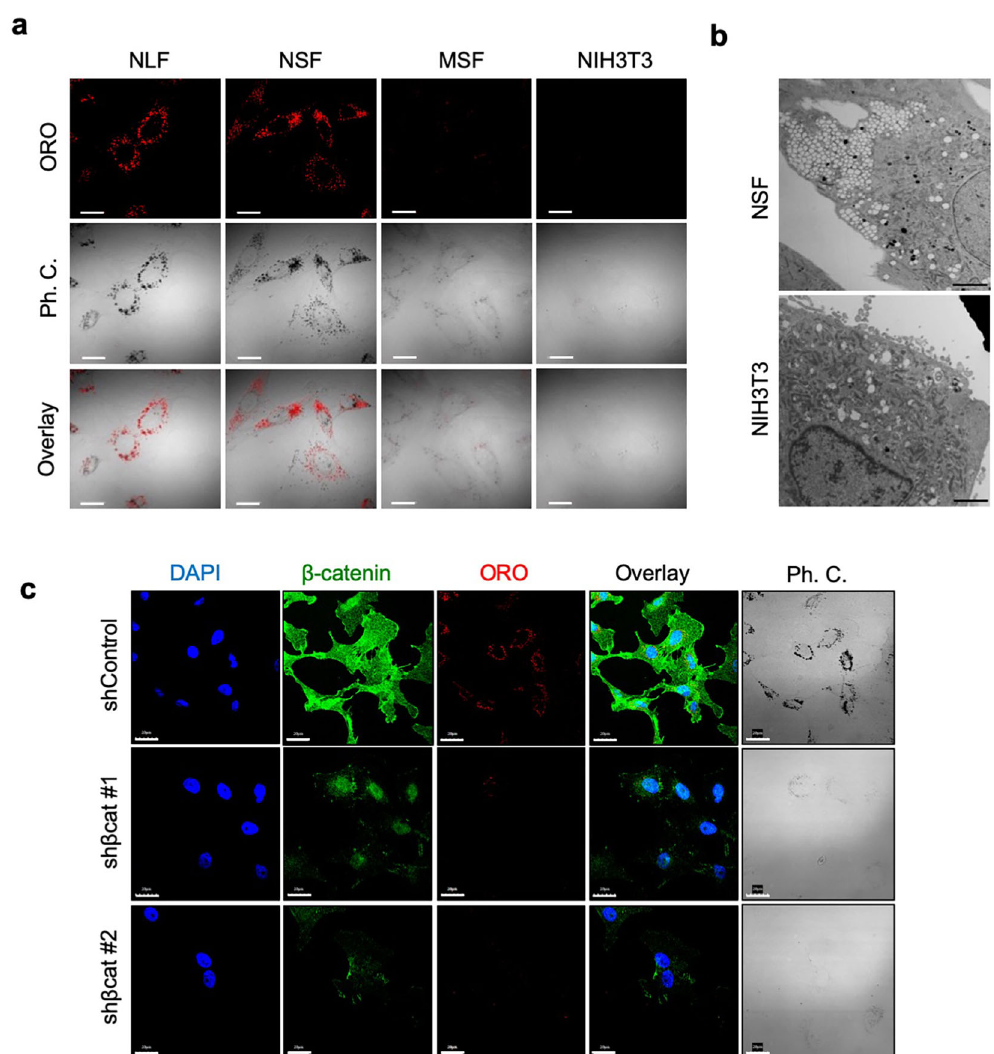
Fig. 3 Association between β -catenin abundance and lipid droplet accumulation. a Representative confocal images showing staining of lipid droplets by ORO in NLFs, NSFs, MSFs, and NIH 3T3 cells. Scale bar, 20 μ m. b Representative TEM images showing robust lipid droplet accumulation in NSFs. Scale bar, 5 μ m. c Representative fl uorescence images of DAPI, β -catenin, and ORO staining, along with phase-contrast images, of control and β -catenin knockdown NSFs. Scale bar, 20 μ